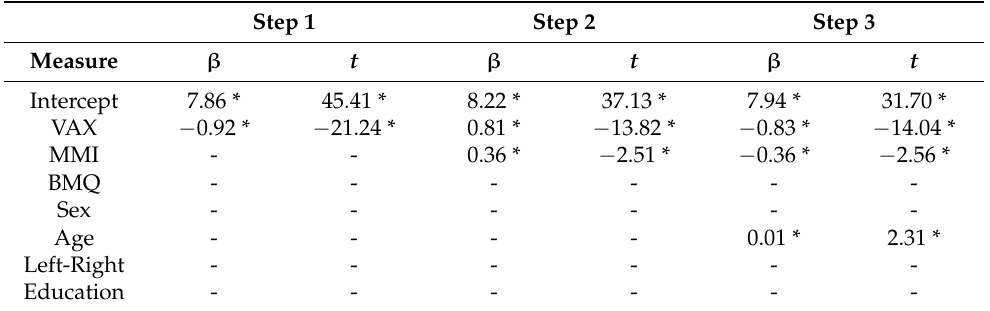
Table 8. Study 2. Summary of stepwise linear regression to predict vaccination intentions. *: p < 0.05.